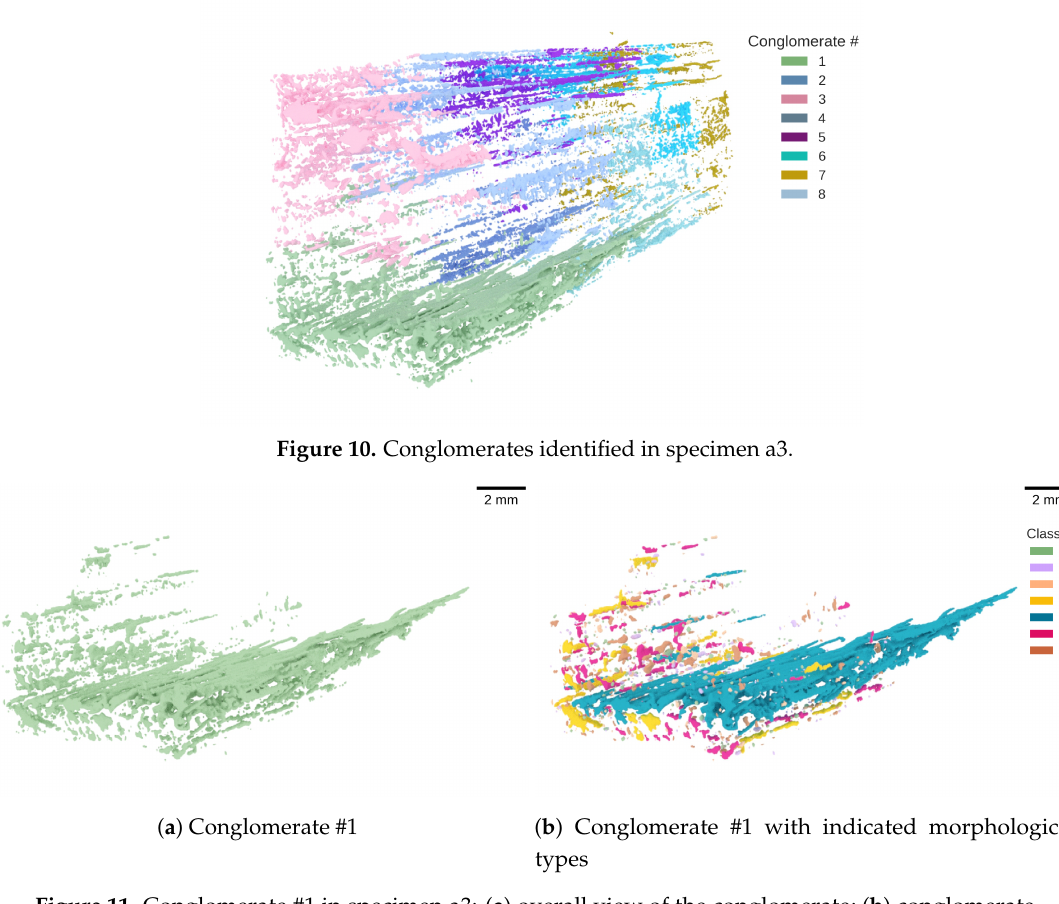
Figure 11. Conglomerate #1 in specimen a3: ( a ) overall view of the conglomerate; ( b ) conglomerate with the morphological types